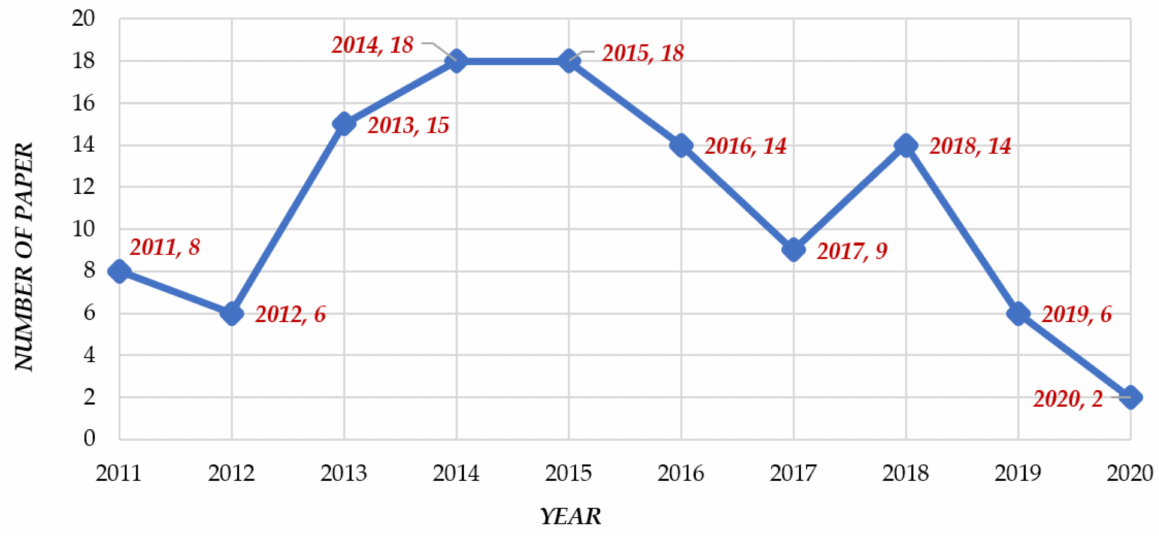
Figure 3. Distribution of 110 most cited papers from 2011 to